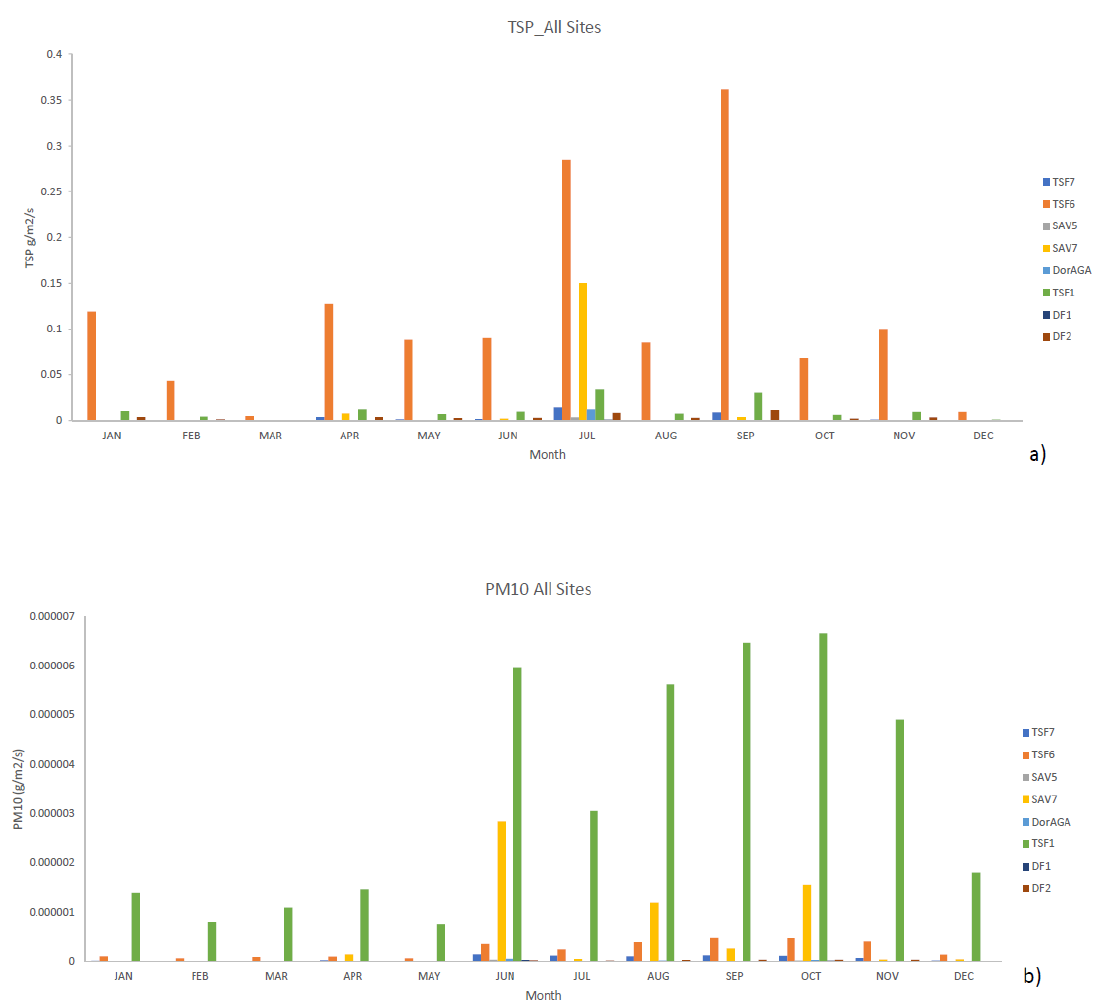
Figure 6. Seasonal emission rates ( a ) TSP and ( b ) PM10.